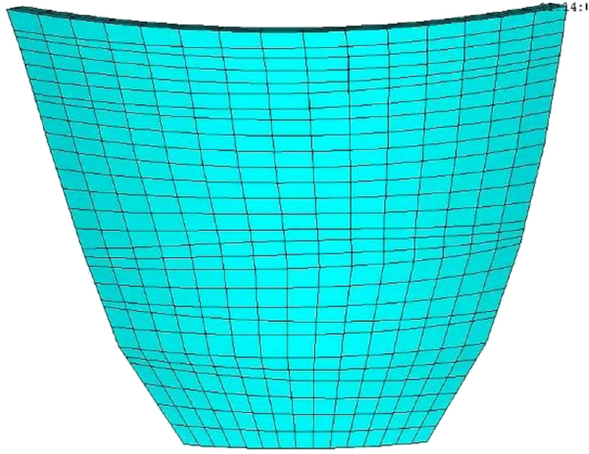
Figure 15: Finite element mesh map of dam body.